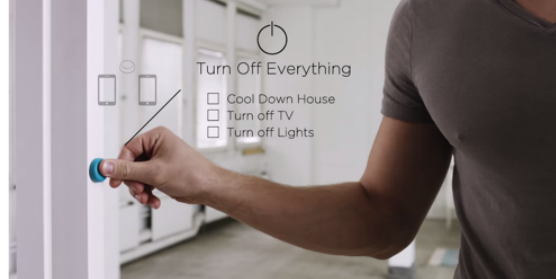
Figure 2 . Wireless Bluetooth button for the smart